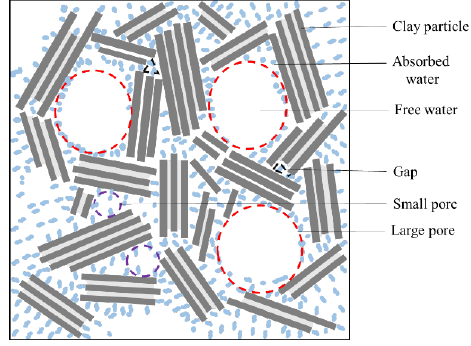
Figure 2. Pore structure of clay in microscope.